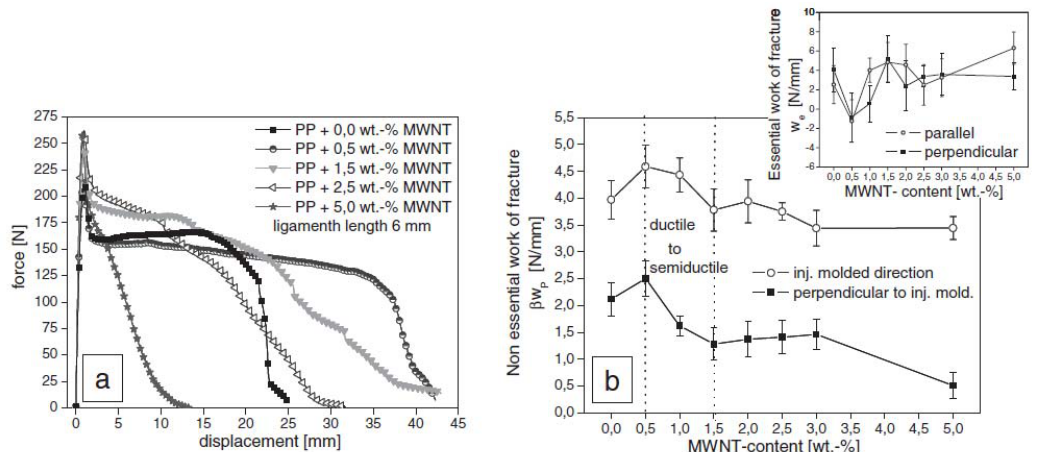
Figure 12. a) Force-displacement diagrams of nanocomposites with different concentrations of MWCNTs for a fixed ligament length ( ≈ 6mm). b) Dependence of non- ) on MWCNTs content. Essential work of fracture ( essential work of fracture ( β Wp versus MWNTs content (insert). Reproduced with permission from ref.